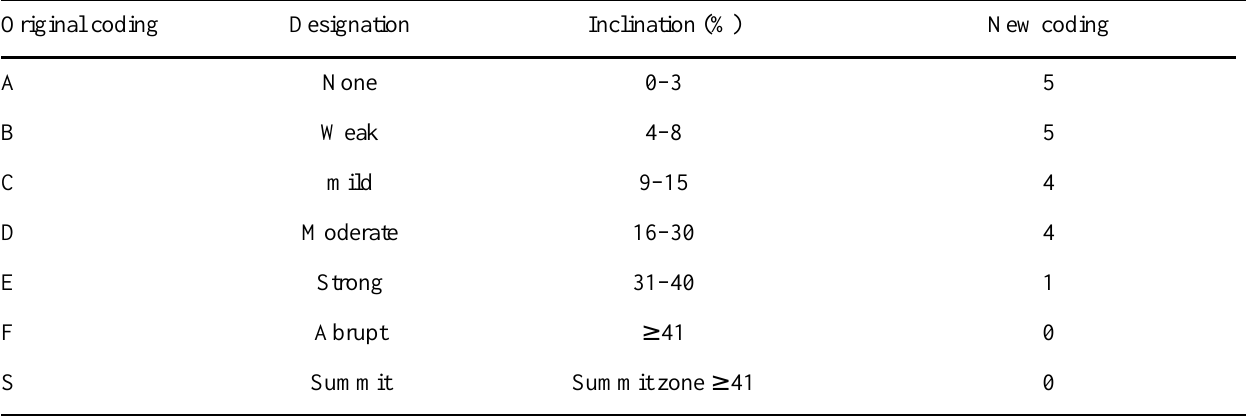
Table 2 . Slope classes obtained from forest maps used to model moose behavior along highways in the Laurentides Wildlife Reserve. Slope class for each forest polygon was obtained from forest maps of the study area. Water bodies, islands, and some other land types had no code, so we changed these to A. Slope classes were then converted to integer values in which 5 represents the flattest slope and 0 the